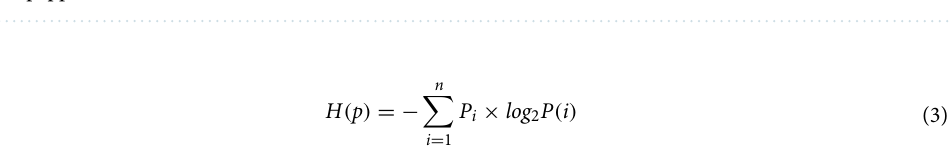
Figure 6. Extracted frames from decrypted video sets at various noise levels for additive Gaussian noise and salt and pepper